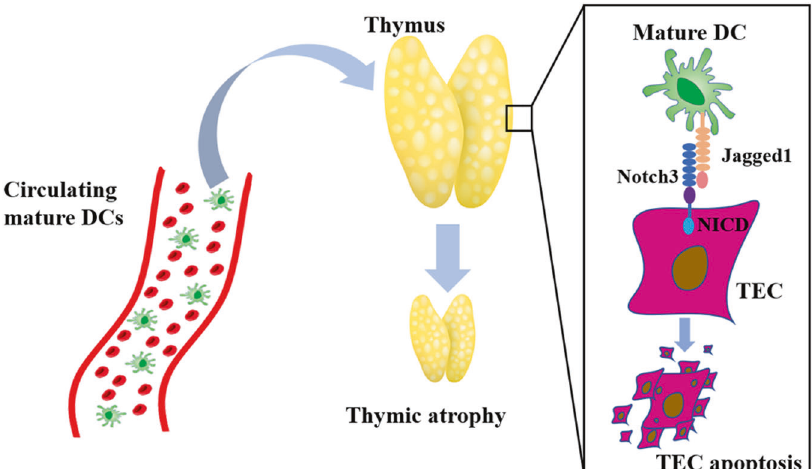
Fig. 7 Research summary: circulating mature DCs homing to the thymus promote thymic epithelial cell involution through the Jagged1/ Notch3 axis. Circulating mDCs can return to the thymus where they interact with TECs through direct cell – cell contact. MDCs can activate Notch signaling in TECs through the Jagged1/Notch3 axis. Long-term Notch signaling activation of TECs results in apoptosis and growth inhibition, further leading to the degeneration of the